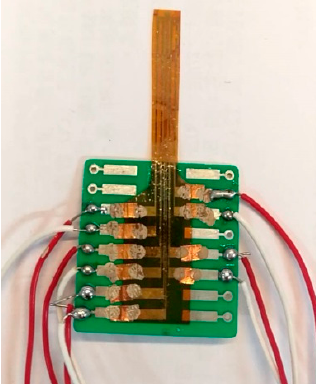
Figure 2. The optical micrograph of the flexible 6-in-1 microsensor.